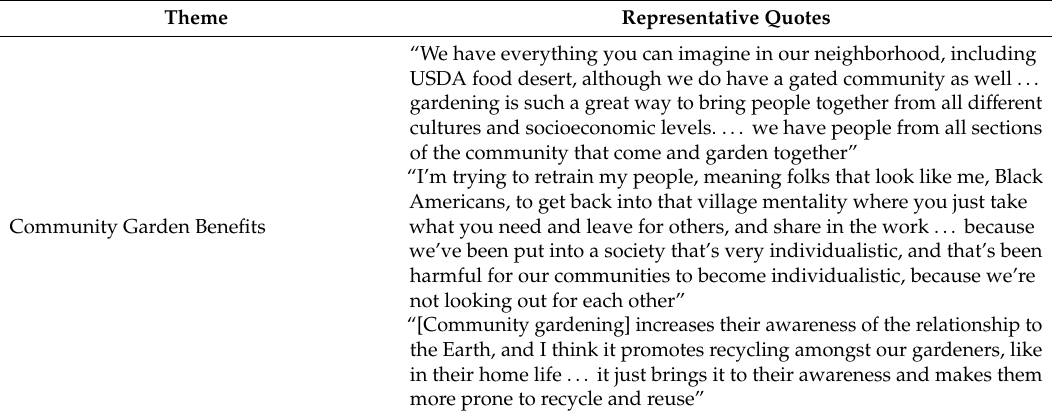
Table A1. Quotes Representing Focus Group